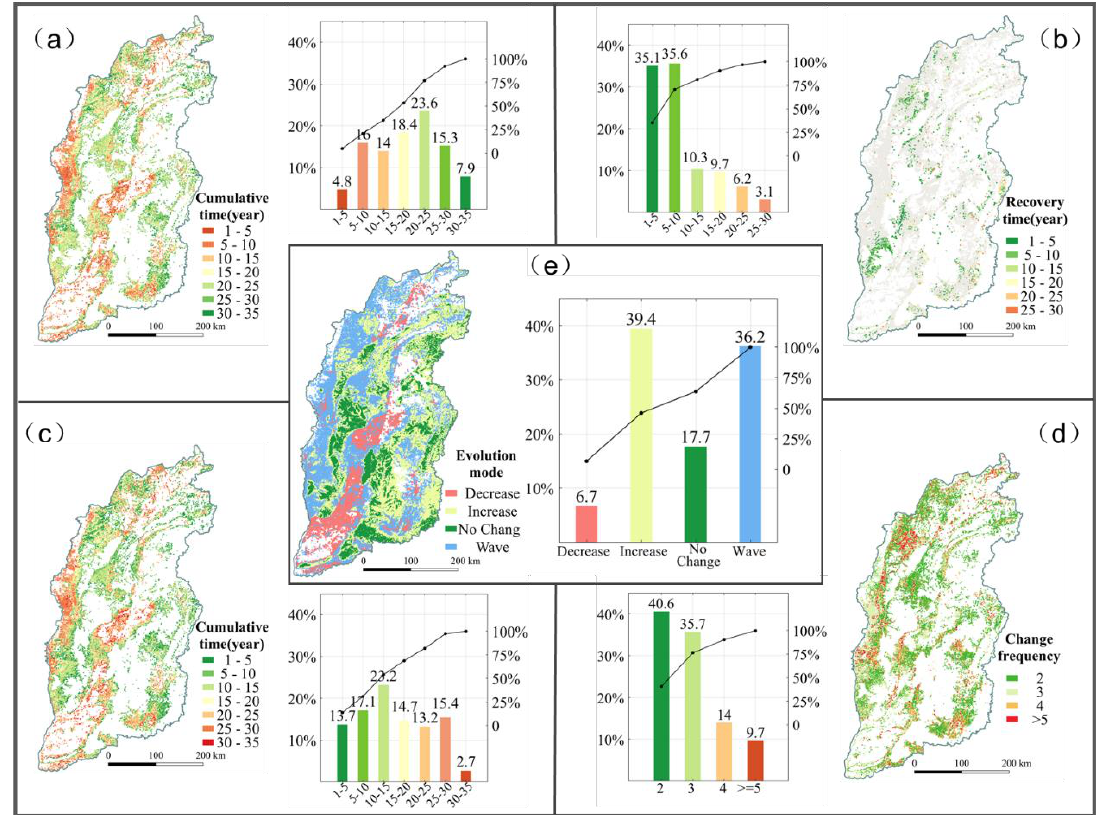
Figure 8. Spatial distribution of evolution modes and landscape stability evaluation index for wave mode: ( a – d ) landscape stability evaluation index for wave mode and ( e ) spatial distribution of evolution